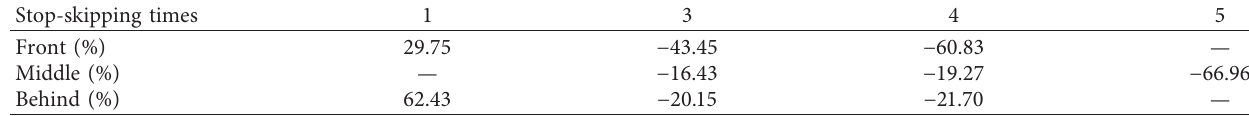
Table 6: Stop-skipping times relative difference compared with group S2.